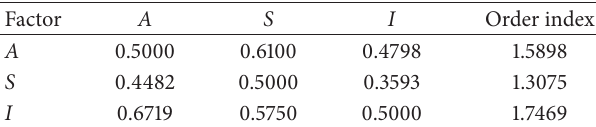
Table 6: Pairwise comparison matrix of 𝑈 1 based on 0.1–0.9 scale.